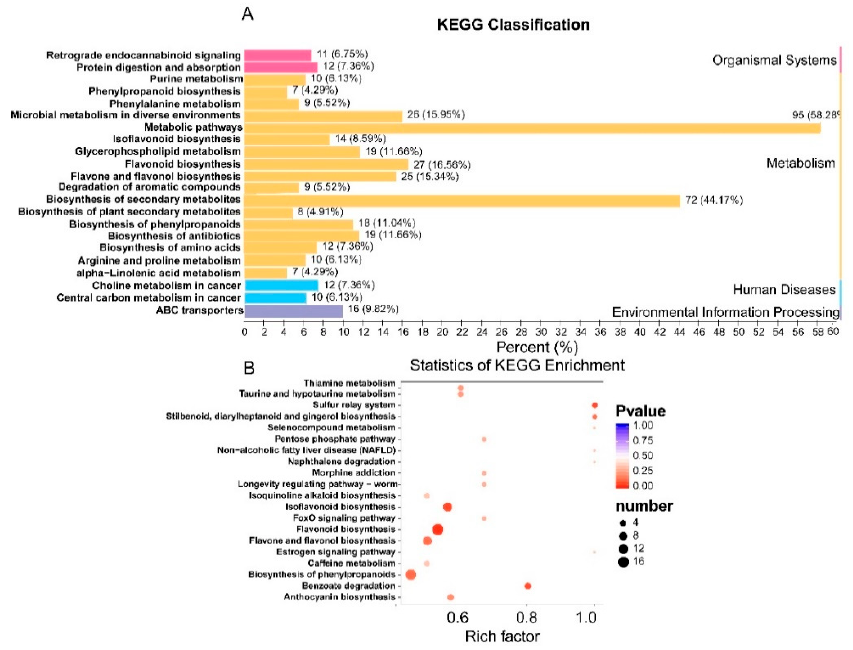
Figure 6. KEGG classification and enrichment of differential flavonoid metabolites for WS versus CS. ( A ) The vertical axis represents the names of the KEGG metabolic pathways, while the horizontal axis gives the ratio of metabolites annotated to a pathway to the total number of annotated metabolites in percentage values. ( B ) The vertical axis represents the enrichment factor of each pathway, while the horizontal axis shows the names of the pathways. The color of each point in this figure represents its P -value; the redder a point, the more significant its enrichment. The size of a point represents the number of differential metabolites that have been annotated to its corresponding pathway.